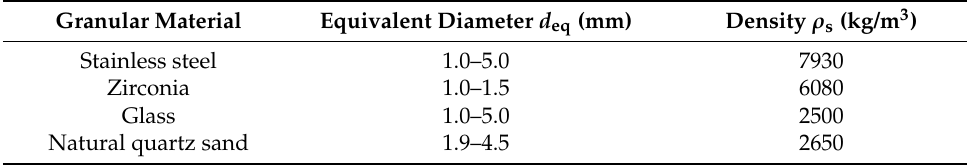
Table 1. Main physical parameters of particles used in the experiment.